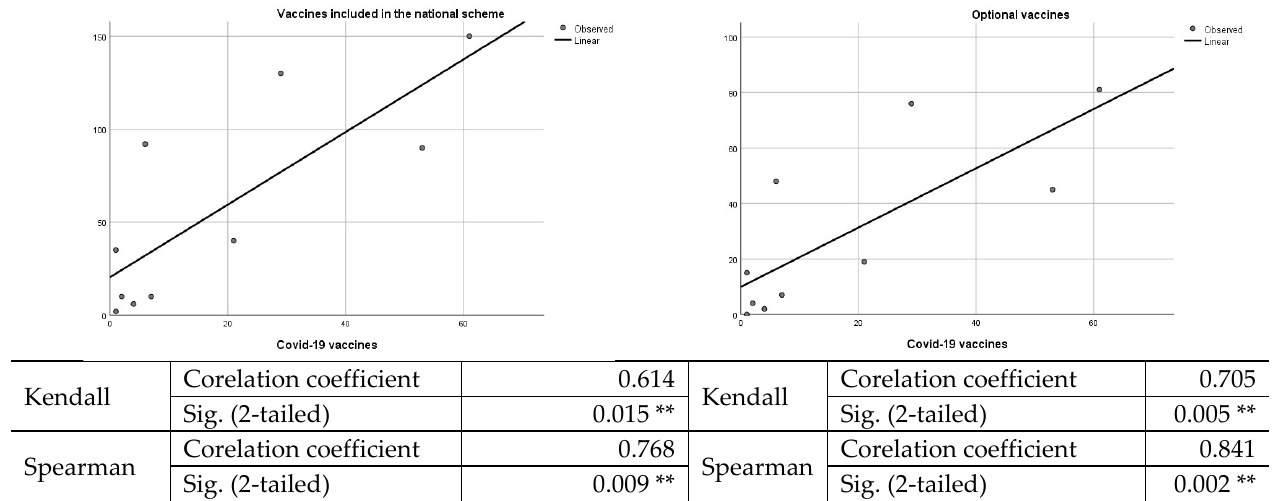
Figure 2. Graphic representation of the correlation between the acceptance of parents/legal guardians of vaccines included in the national vaccination schedule, optional vaccines, and the COVID-19 vaccine. **. Correlation is significant at the 0.01 level (2-tailed). Comparative analyses among vaccines included in the national scheme, optional vaccines (like rotavirus vaccine, hepatitis A and B, meningococcal vaccine etc.), and anti-